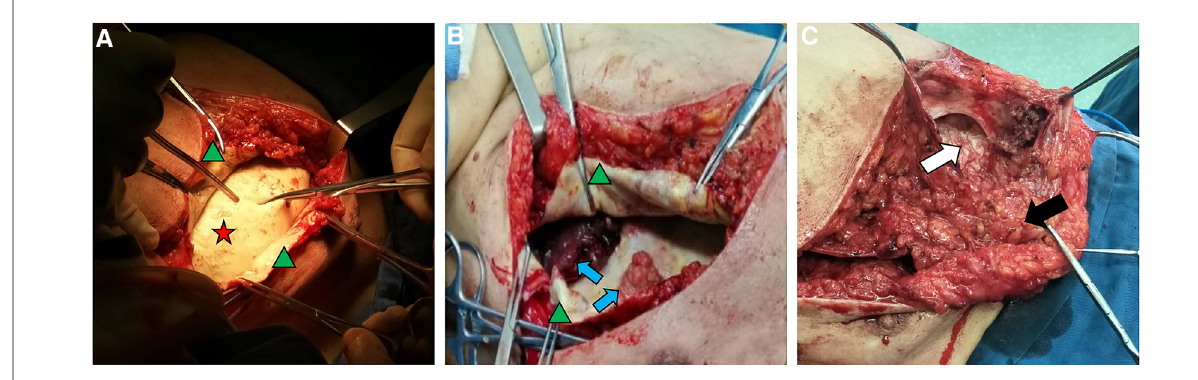
FIGURE 2 Intraoperative appearance of the implant and the mass. The implant (red star) was intact ( A ); Formation of capsule (green triangle) and presence of several heterogeneous nodules composed of liquid- fi llen spaces in which solid papillae project (blue arrow) were observed ( B ); A polycystic tumor was in front of the implant composed of solid tumor zones (black arrow) and cystic tumor zones (white arrow) ( C